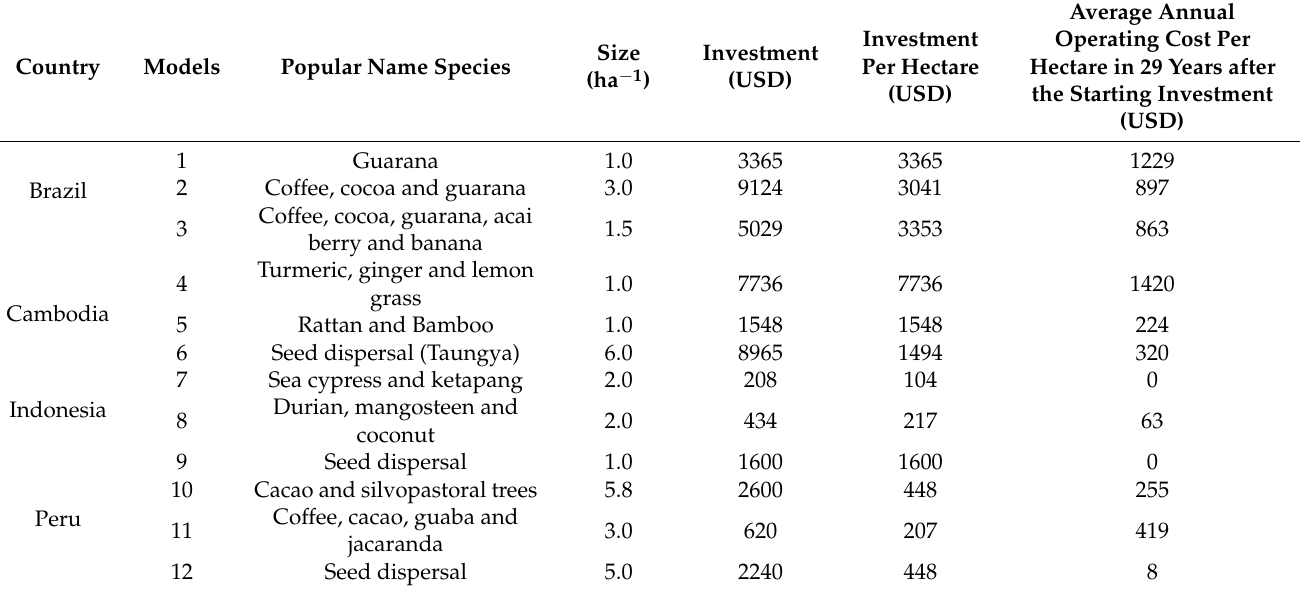
Table 3. Investments for 12 tropical forest restoration models found in 2018 and 2019 in four